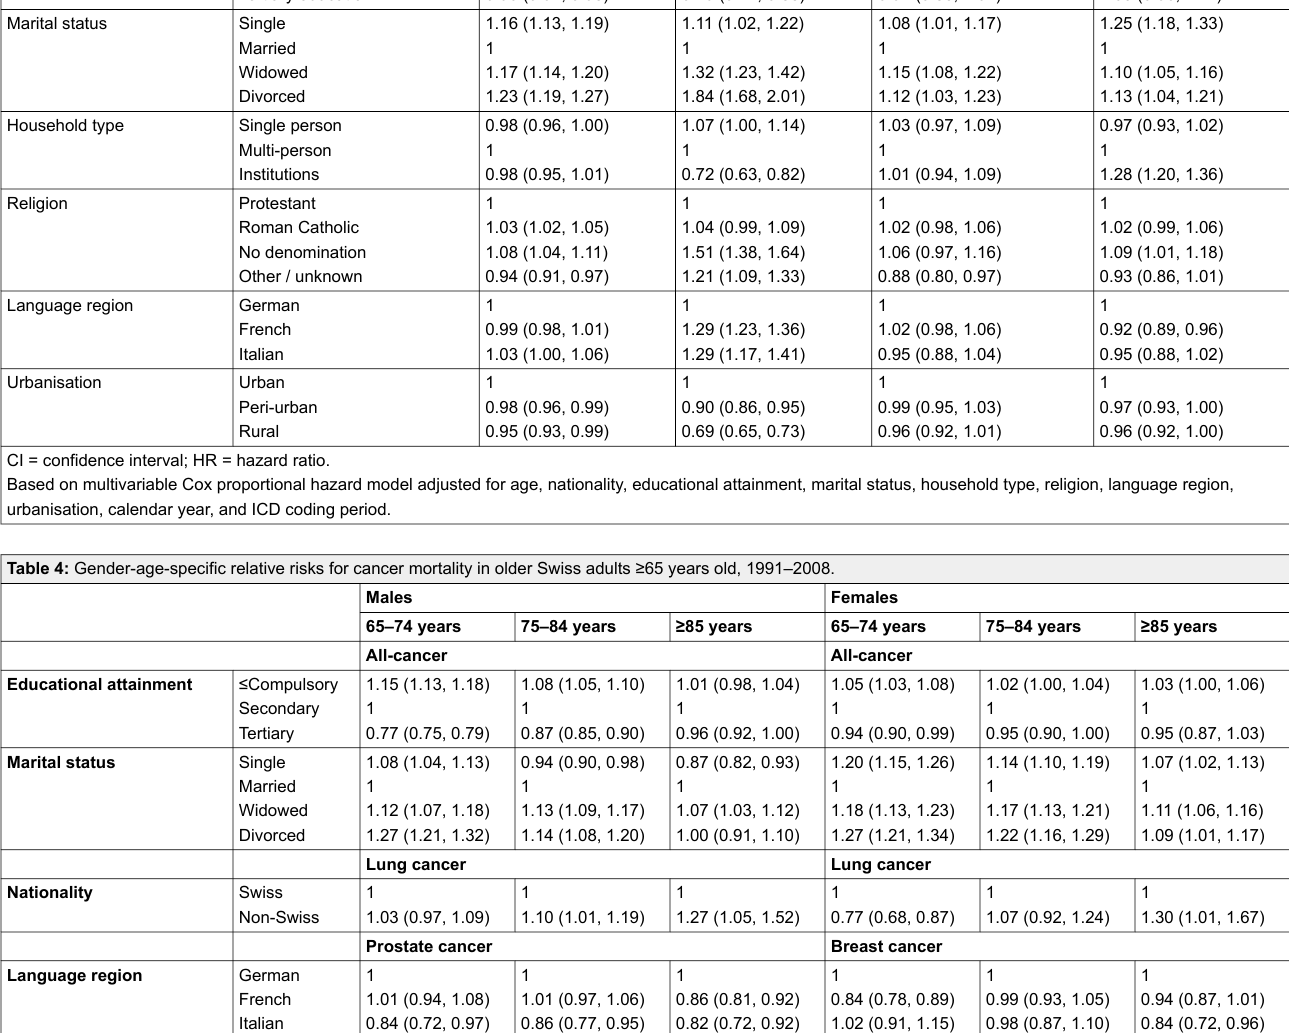
CI = confidence interval; HR = hazard ratio. Based on multivariable Cox proportional hazard model adjusted for age, nationality, educational attainment, marital status, household type, religion, language region, urbanisation, calendar year, and ICD coding